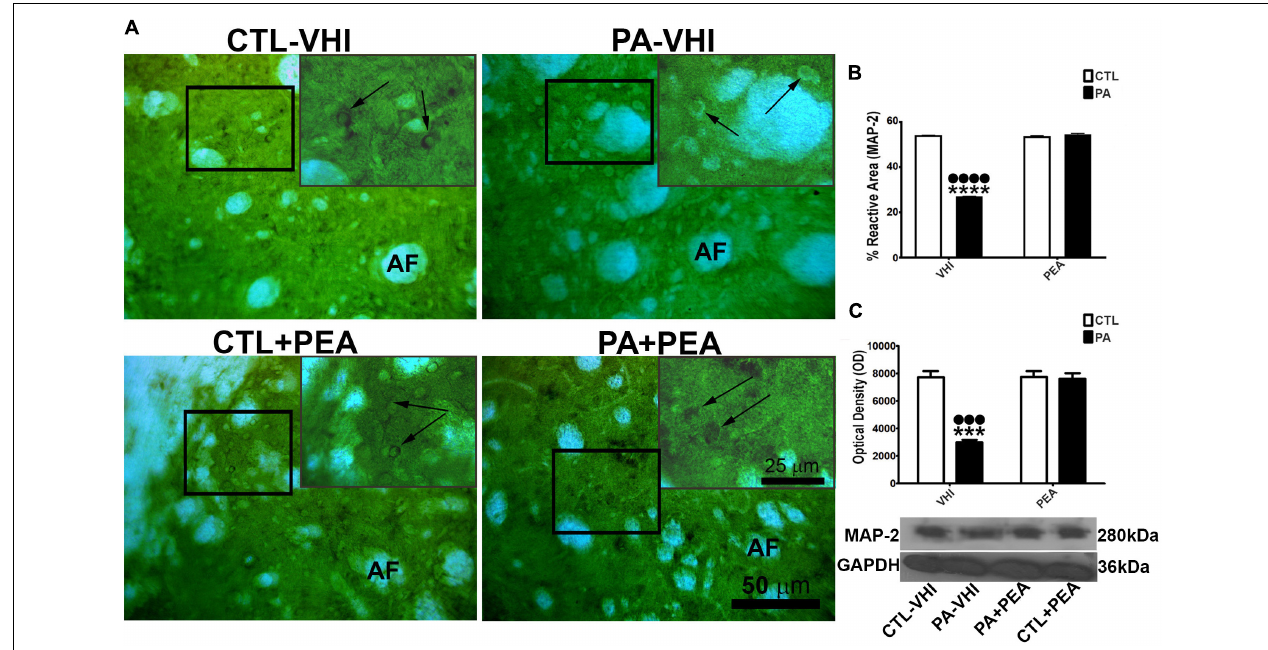
FIGURE 2 | Microtubule-associated protein (MAP-2) immunostaining and protein level in the rat striatum in the experimental groups. (A) Representative images of the dorsal striatum immunostained for MAP-2. The figure shows MAP-2 immunostaining in the dorsal striatum; AF indicates the axonal fascicles. Scale bar: 50 µ m. The main-image marked rectangular areas are shown magnified in the corresponding upper right margin. The black arrow indicates the positive immunostaining area for MAP-2. Scale bar: 25 µ m. (B) Percentage of MAP-2 reactive area. (C) Optical density of bands showing for MAP-2 protein expression level. Bars and error bars represent the mean ± SEM. Two-way ANOVA followed by Tukey’s post hoc test. ∗∗∗∗ p < 0.0001 and ∗∗∗ p < 0.001, PA–VHI vs. CTL–VHI; •••• p < 0.0001 and ••• p < 0.001, PA–VHI vs. PA+PEA. PEA had no effect on either MAP-2 immunostaining or protein expression level as there was no difference between CTL+PEA and CTL–VHI groups. No difference was found in MAP-2 immunostaining or protein expression level between PA+PEA and CTL–VHI groups. CTL–VHI, control rats treated with vehicle; PA–VHI, rats subjected to PA and treated with vehicle; PA+PEA, rats subjected to PA and PEA treatment; CTL+PEA, control rats treated with